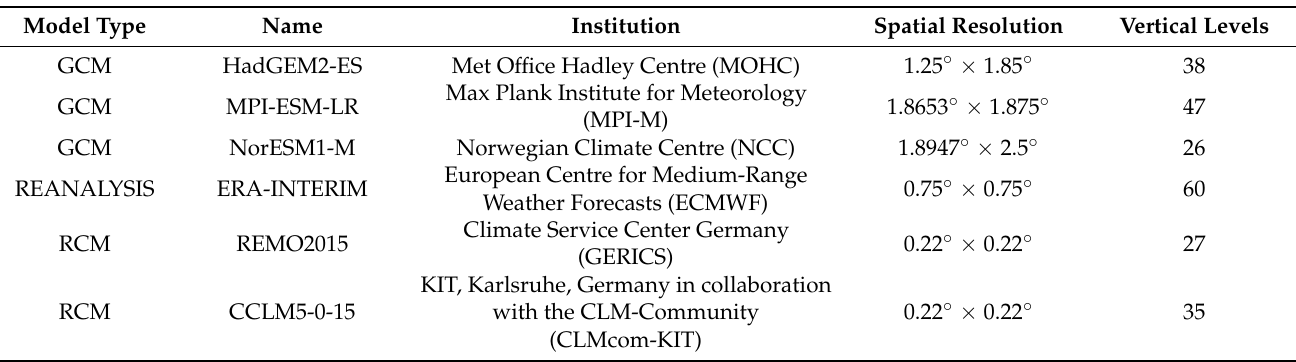
Table 1. Regional Climate Models (RCMs) of the CORDEX-CORE ensemble, and their driving Global Climate Models (GCM) and reanalysis used in this